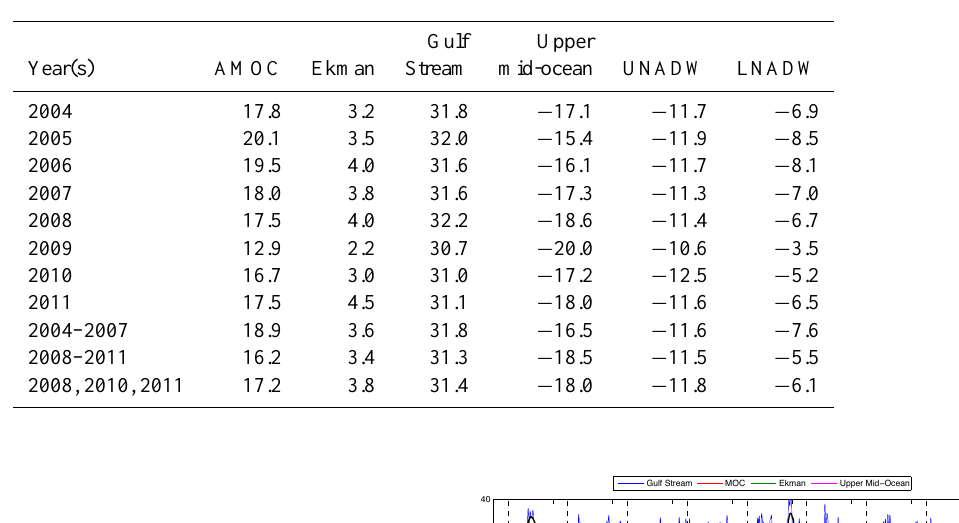
Table 1. Annual averages of the AMOC and its components. Each annual average is for a 12 month period that starts on 1 April of the named year. Also shown are multi-year averages. All values are in Sv. Positive is northward.